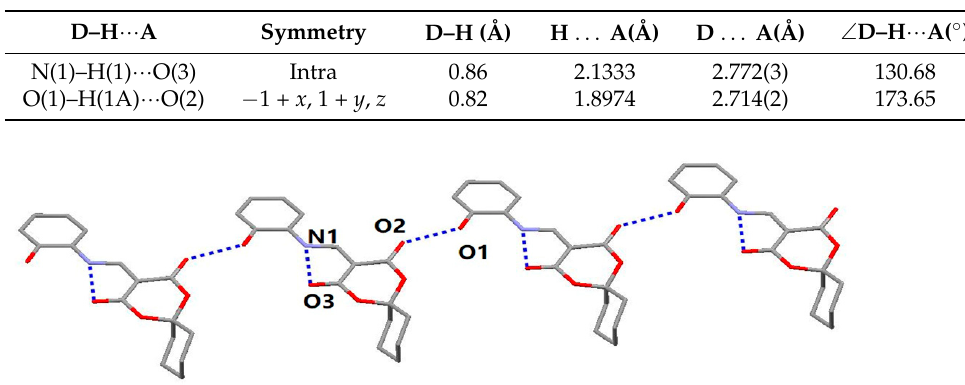
Figure 2. The 1D-chained structure for HMD.